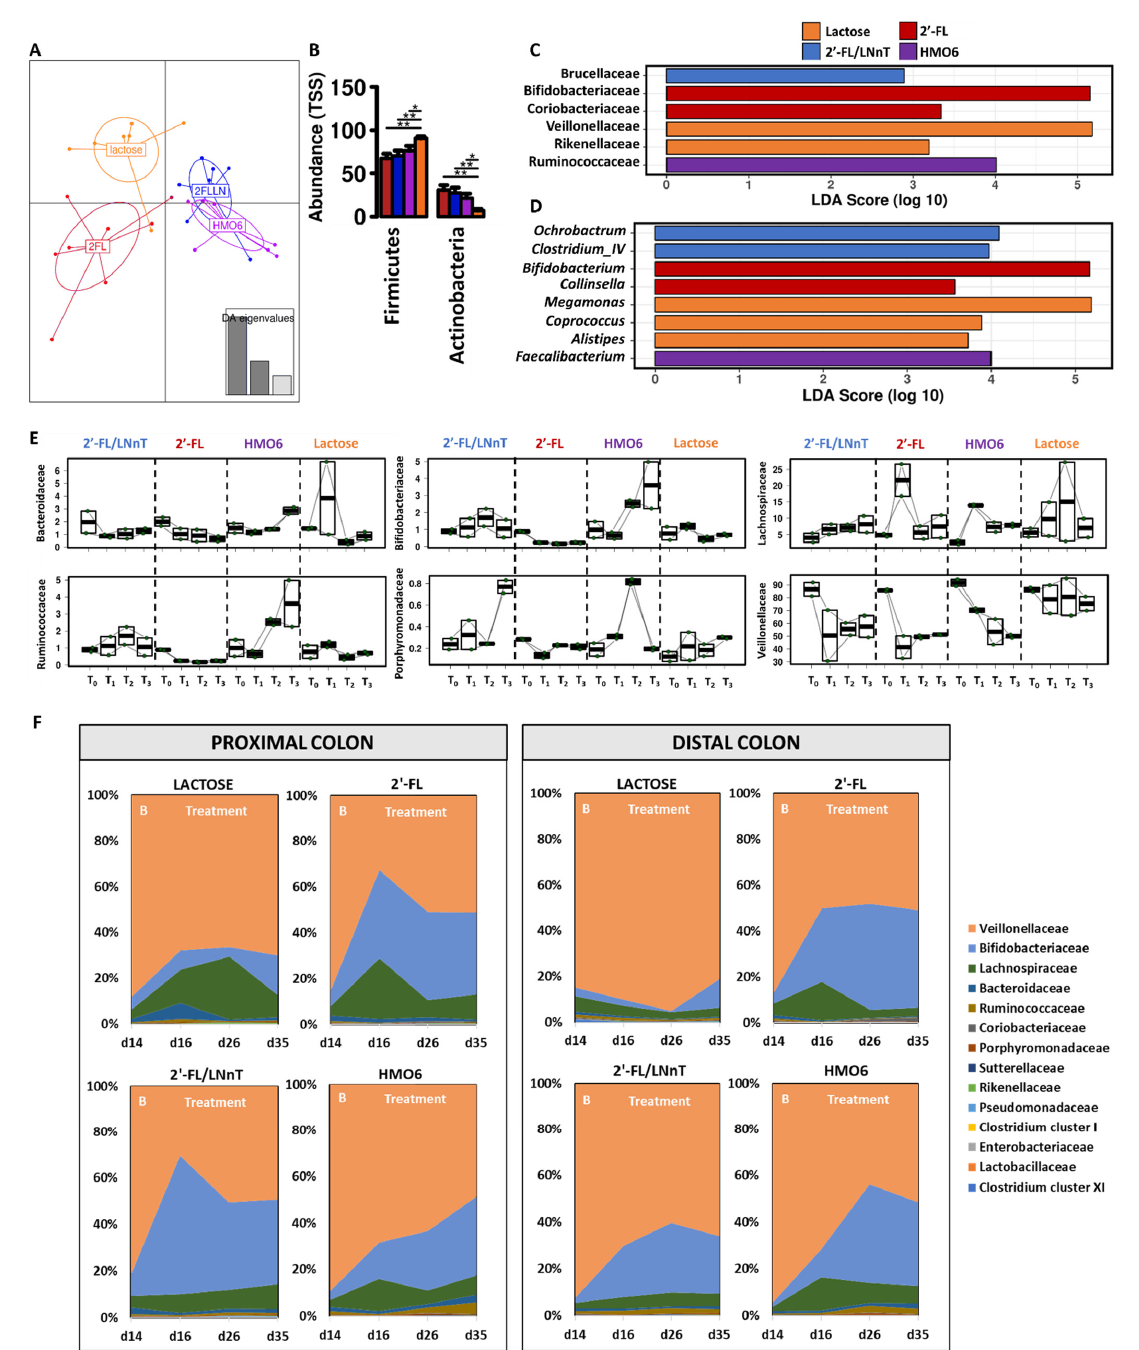
Figure 5. Effect of lactose, 2 ′ -FL, 2 ′ -FL/LNnT, and HMO6 on baby M-SHIME ® microbiota structure. ( A ) Discriminant Analysis of Principal Components (DAPC) of the luminal PC and DC at the family level. ( B ) Bar plot and ANOVA analysis at the phylum level. Linear Discriminant Analysis Effect Size (LEfSe) at the family ( C ) and genus ( D ) level of the luminal compartment. ( E ) Selected features significantly affected by different treatments at the genus level using a mixed effect model. ( F ) Proportional abundance at the family level (%) of a breastfed infant microbiota before (day 14) and after treatment with lactose, 2 (cid:48) -FL, 2 (cid:48) -FL/LNnT or HMO6 in the luminal proximal (PC) and distal colon (DC) of the baby M-SHIME ® . B: Baseline. T 0 = start of the experiment, T 1 = 7 days, T 2 = 14 days, T 3 = 21